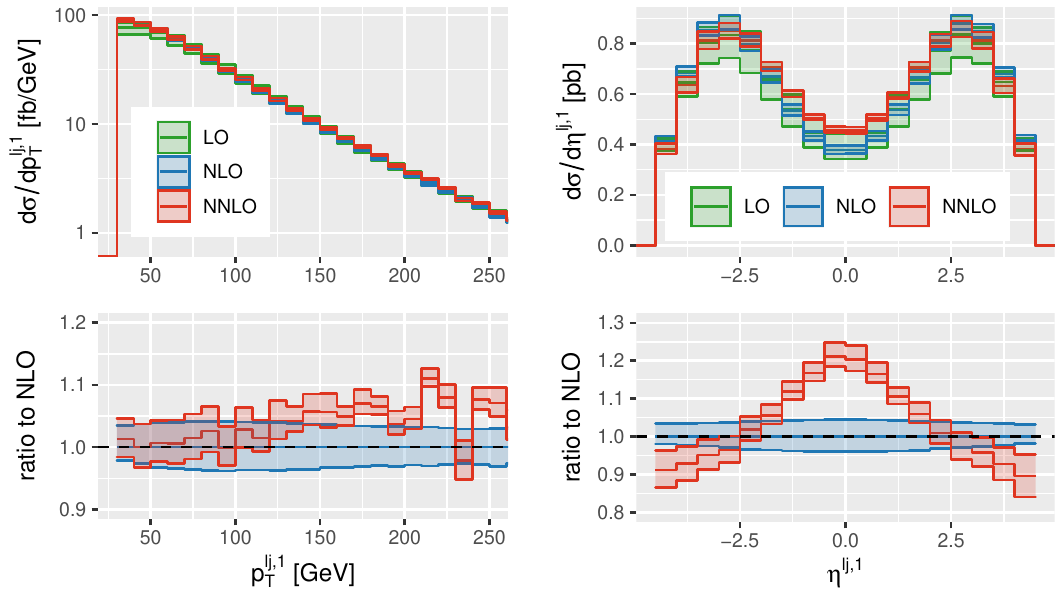
Figure 12 . p T -leading light jet transverse momentum distribution (left) and pseudorapidity dis- tribution (right).